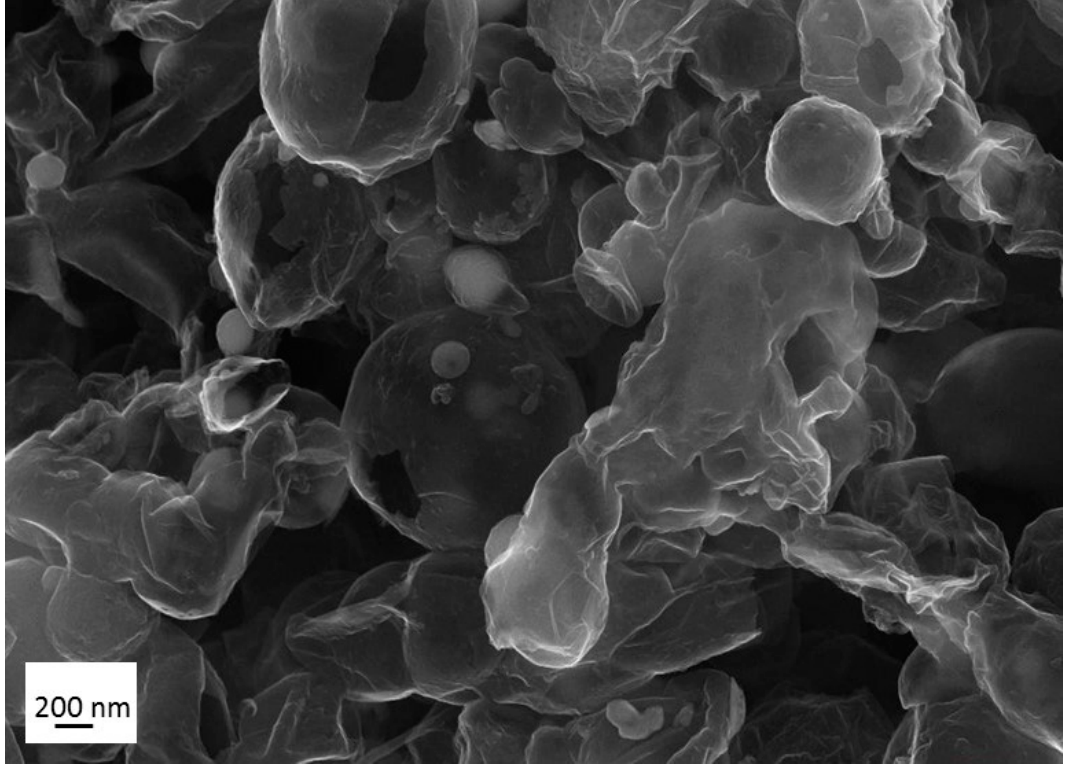
Figure A2. Scanning electron microscopy image of a sample obtained from LPM-1 at R = 0.61 after acid leaching.